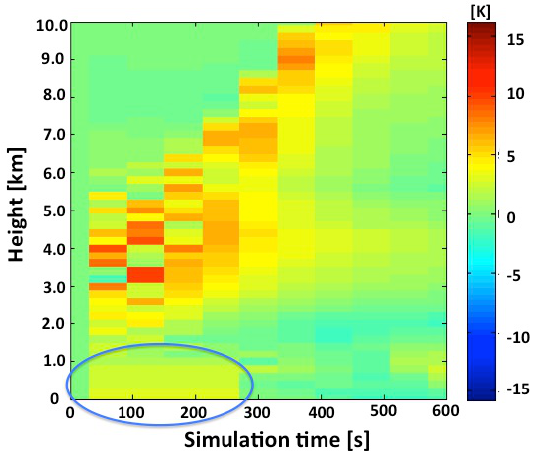
Fig. 3. Temperature perturbation from the basic state for the EMTM model initialization, as a function of model simulation time and alti- tude. The different colors represent the temperature deviation from the basic state due to the evolution of the cloud.